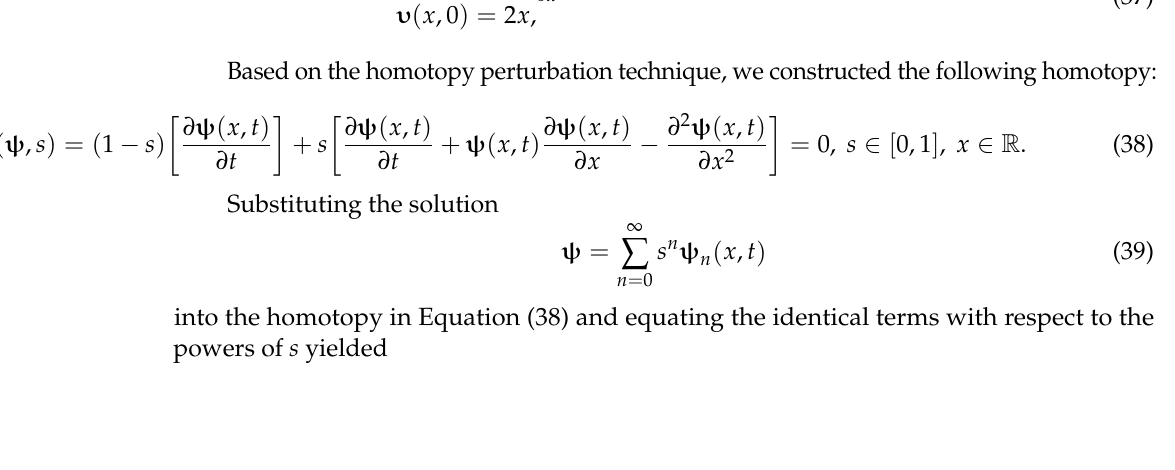
Figure 2. ( a ) A comparison between the exact solution υ ( x ) and the series solution V 3 ( x ) ; ( b ) absolute error | υ ( x ) − V 3 ( x ) | .